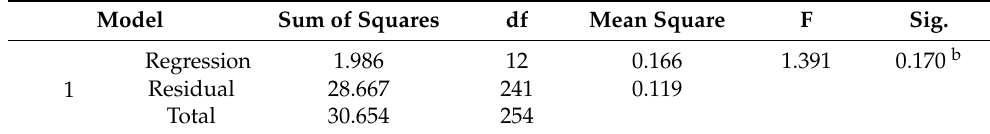
Table 9. ANOVA test.